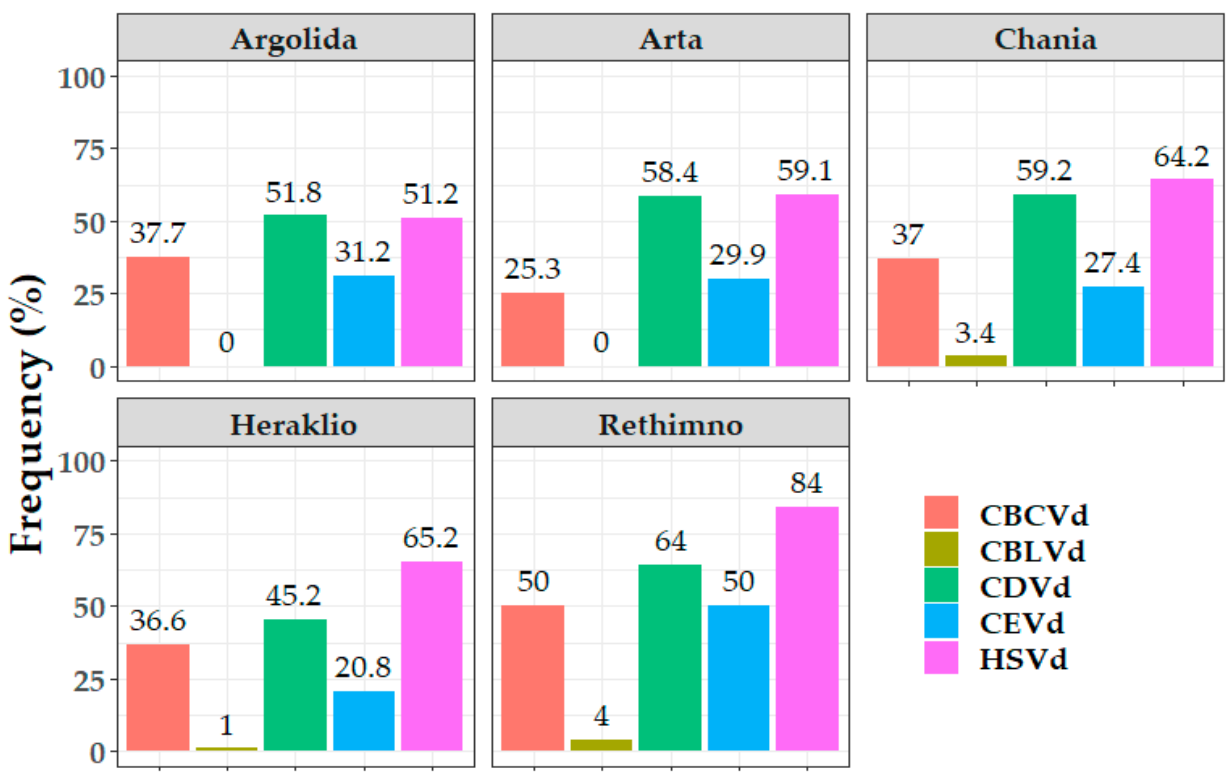
Figure 3. Frequency (%) of citrus viroids in the overall number of samples collected from each geographical district of Greece.